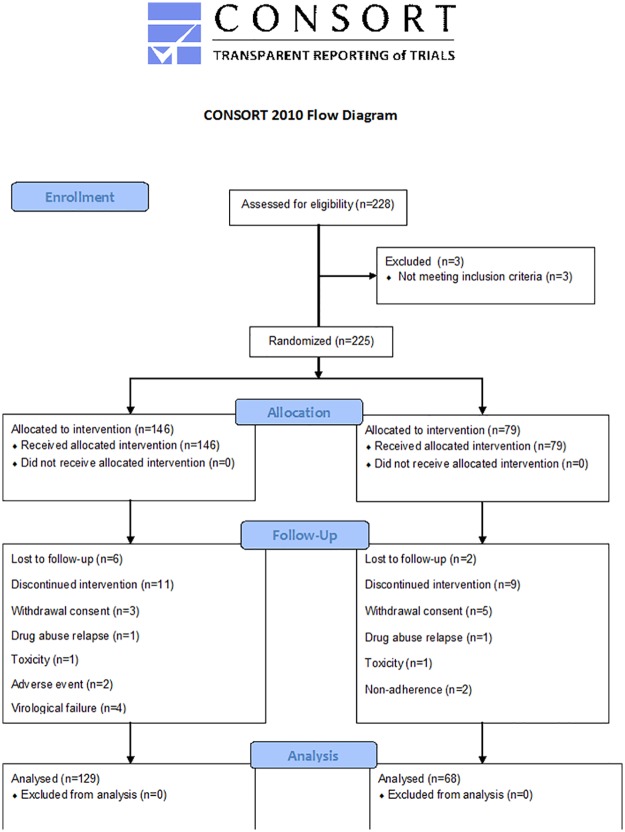
CONSORT flow diagram showing disposition of patients throughout the study from baseline to week 24.